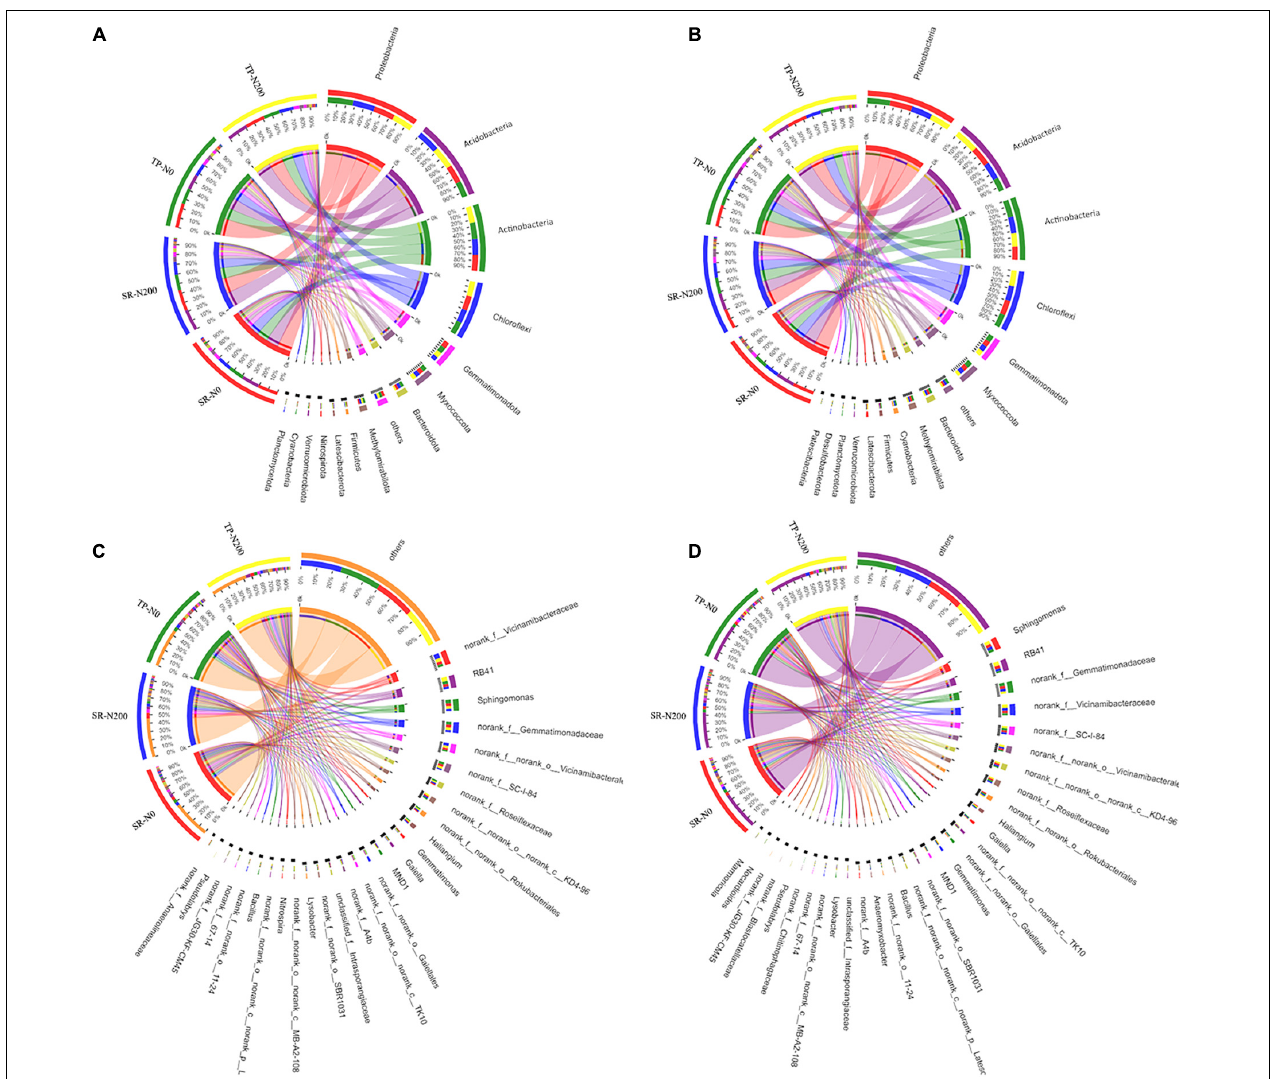
FIGURE 3 | Relative abundances of bacterial in spring (A) and autumn (B) communities at the phylum level, and abundance at the genes level in spring (C) and autumn (D) seasons. SR-N0 = straw returning without N fertilizer application; SR-N200 = straw returning with 200 kg ha − 1 N fertilizer application; TP-N0 = traditional planting without N fertilizer application; TP-N200 = traditional planting with 200 kg/ha nitrogen fertilizer